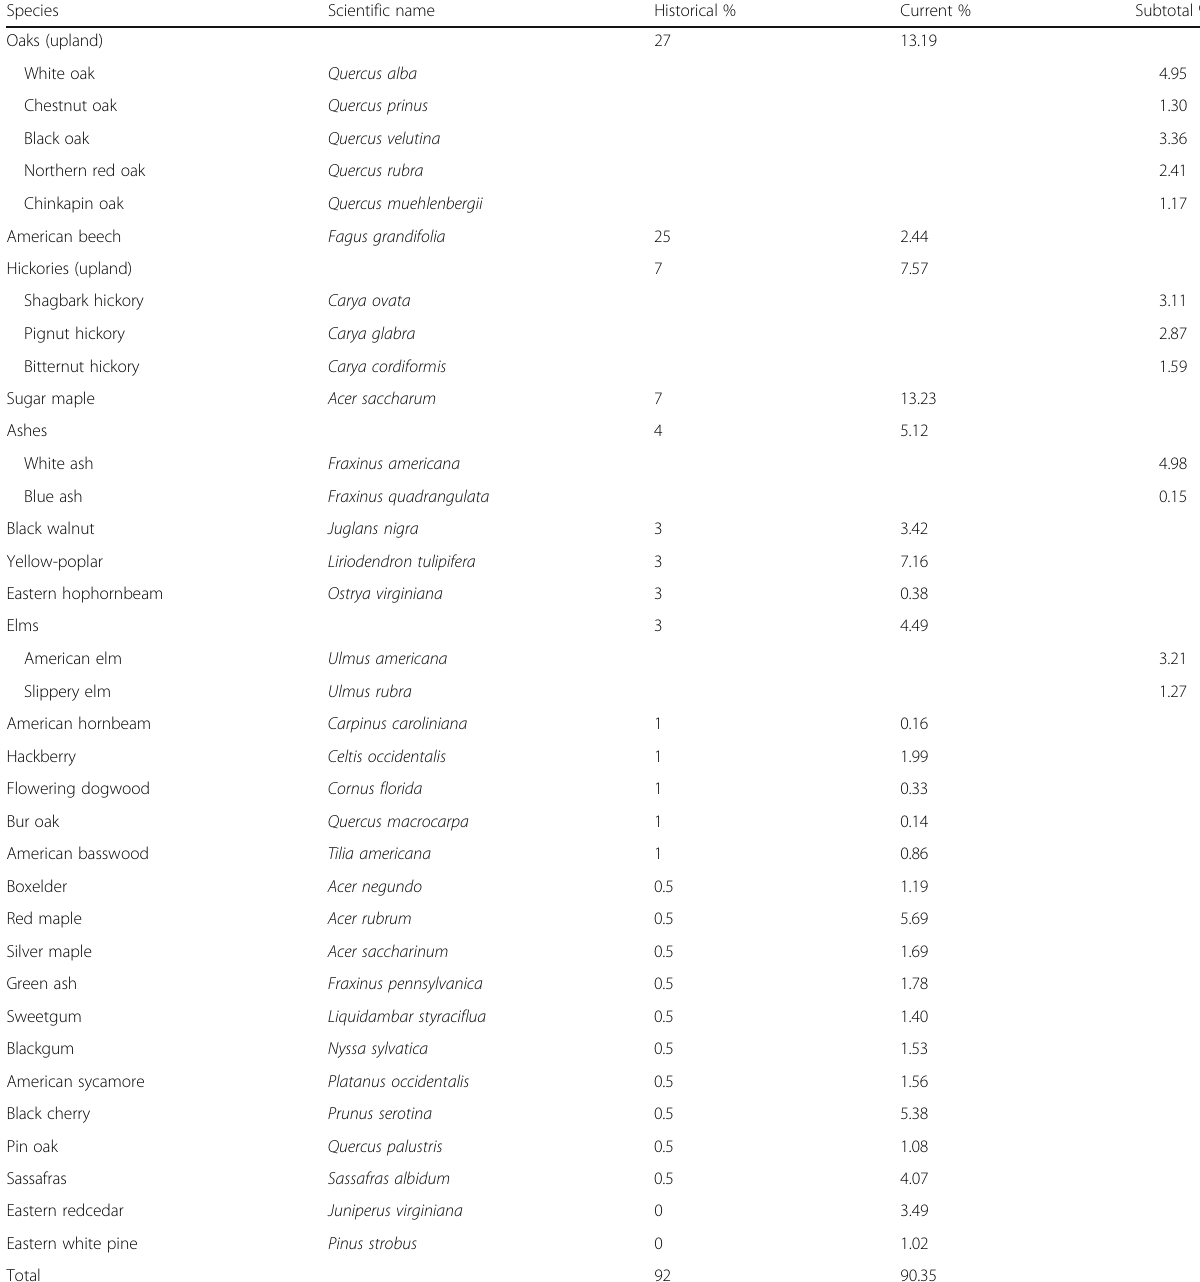
Table 1 Historical (1799 to 1846) and current (2009 to 2013) forest composition (% of all trees) in Indiana. Subtotals provide current percentages for species within a